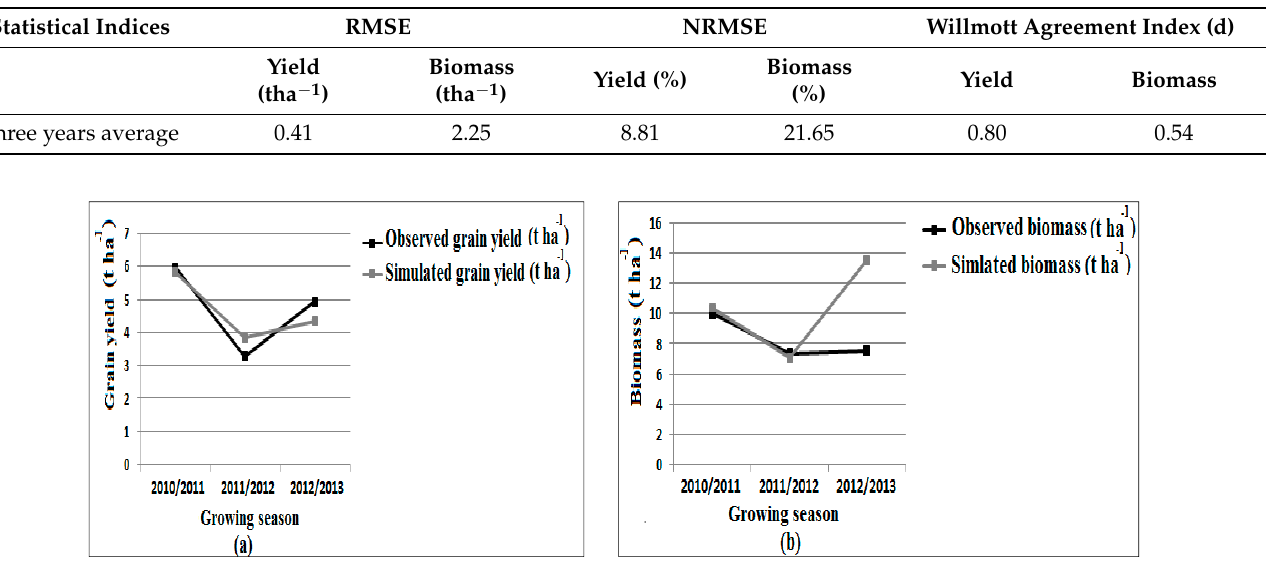
Table 4. Comparison of Mexicali cultivar’s yields and above-ground biomasses observed and simulated by AquaCrop in the 2010/2011, 2011/2012 and 2012/2013 growing seasons.